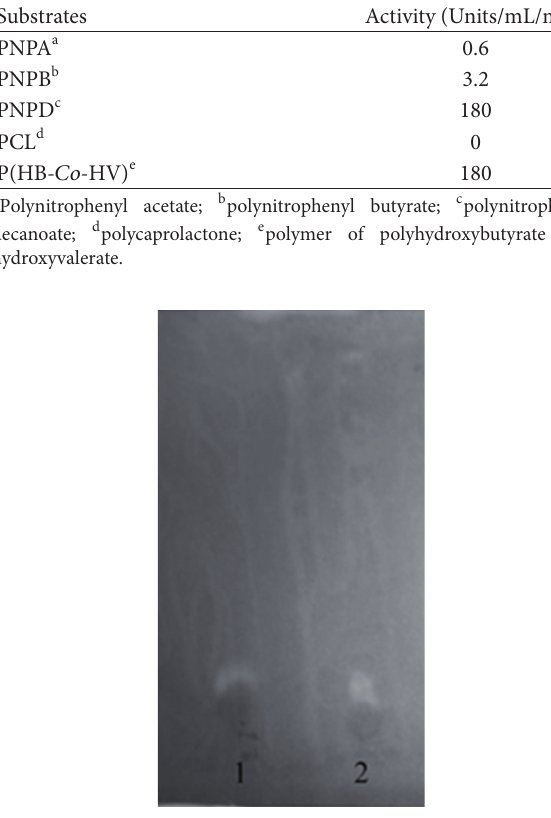
F 12: Identi�cation of PHB hydrolysis end products by PHB depolymerase of F. solani. Lane 1— -hydroxybutyrate standard, Lane 2—end-product of PHB depolymerase 𝛽𝛽